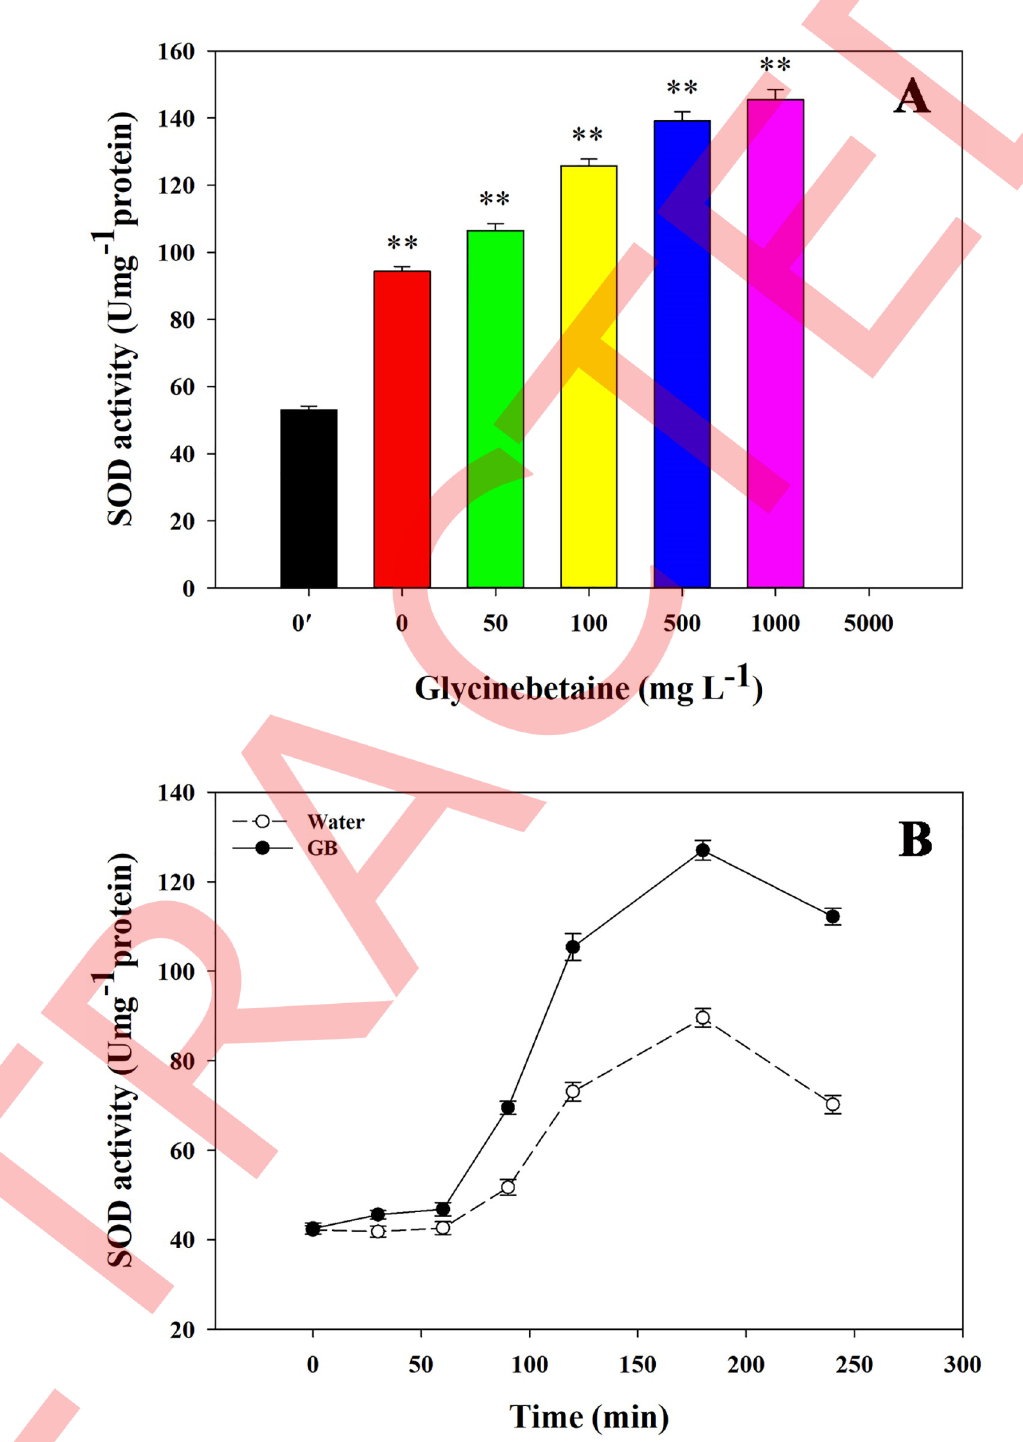
Fig 6. Glycinebetaine (GB) treatment affects SOD activity in severed pear leaves in a dose- (A) and time-dependent manner (B). Detached pear leaves were treated with varying amounts with a GB solution for 10 min, and their water was then spontaneously lost through up to 15% evaporation or for a different duration (B) of the initial fresh weight (A). As described in the Materials and methods section, SOD activity was determined. In A, nondehydrated, non-GB- treated leaves were used as controls (0’). Important contrast is shown by the asterisks compared to the controls (0’) ( �� P < 0.01, Student 0 s t -test). Three replicates are shown as means ± SD.